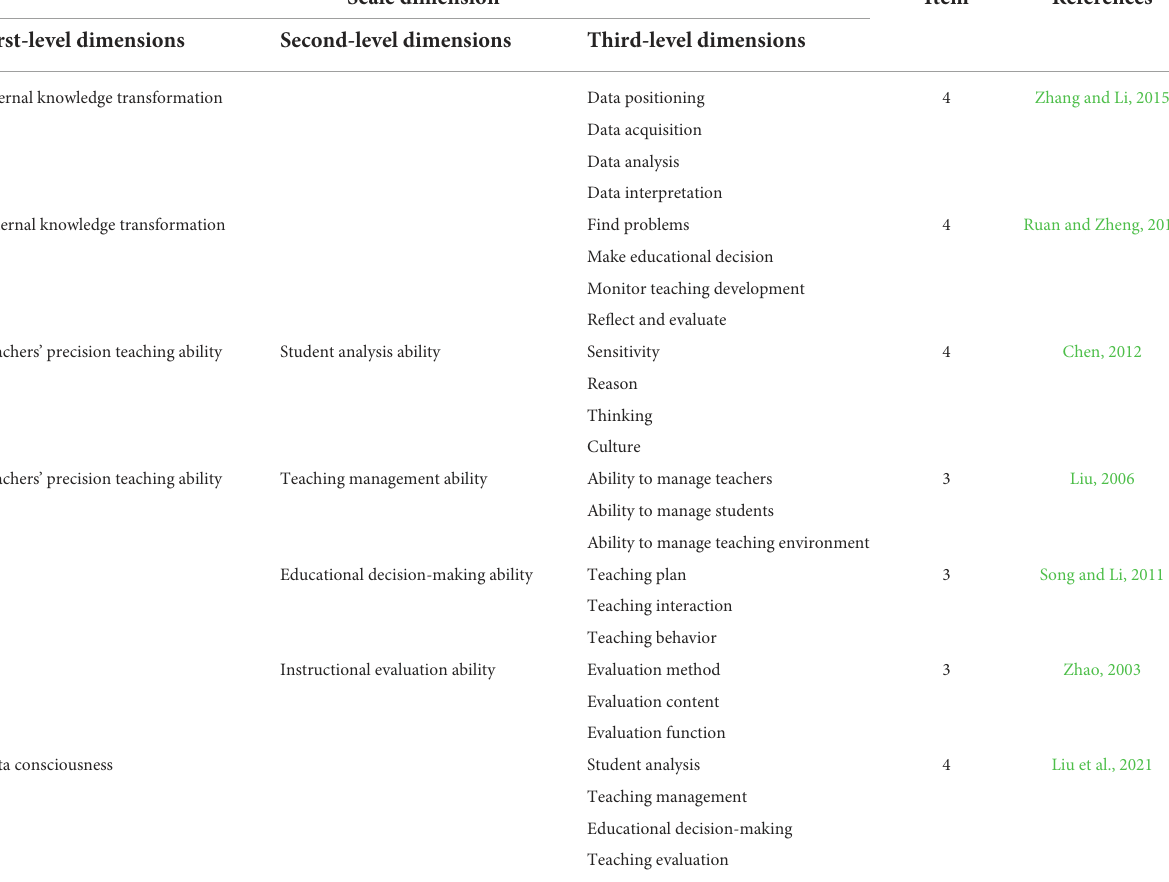
TABLE 1 Reference source and items of measuring scale.